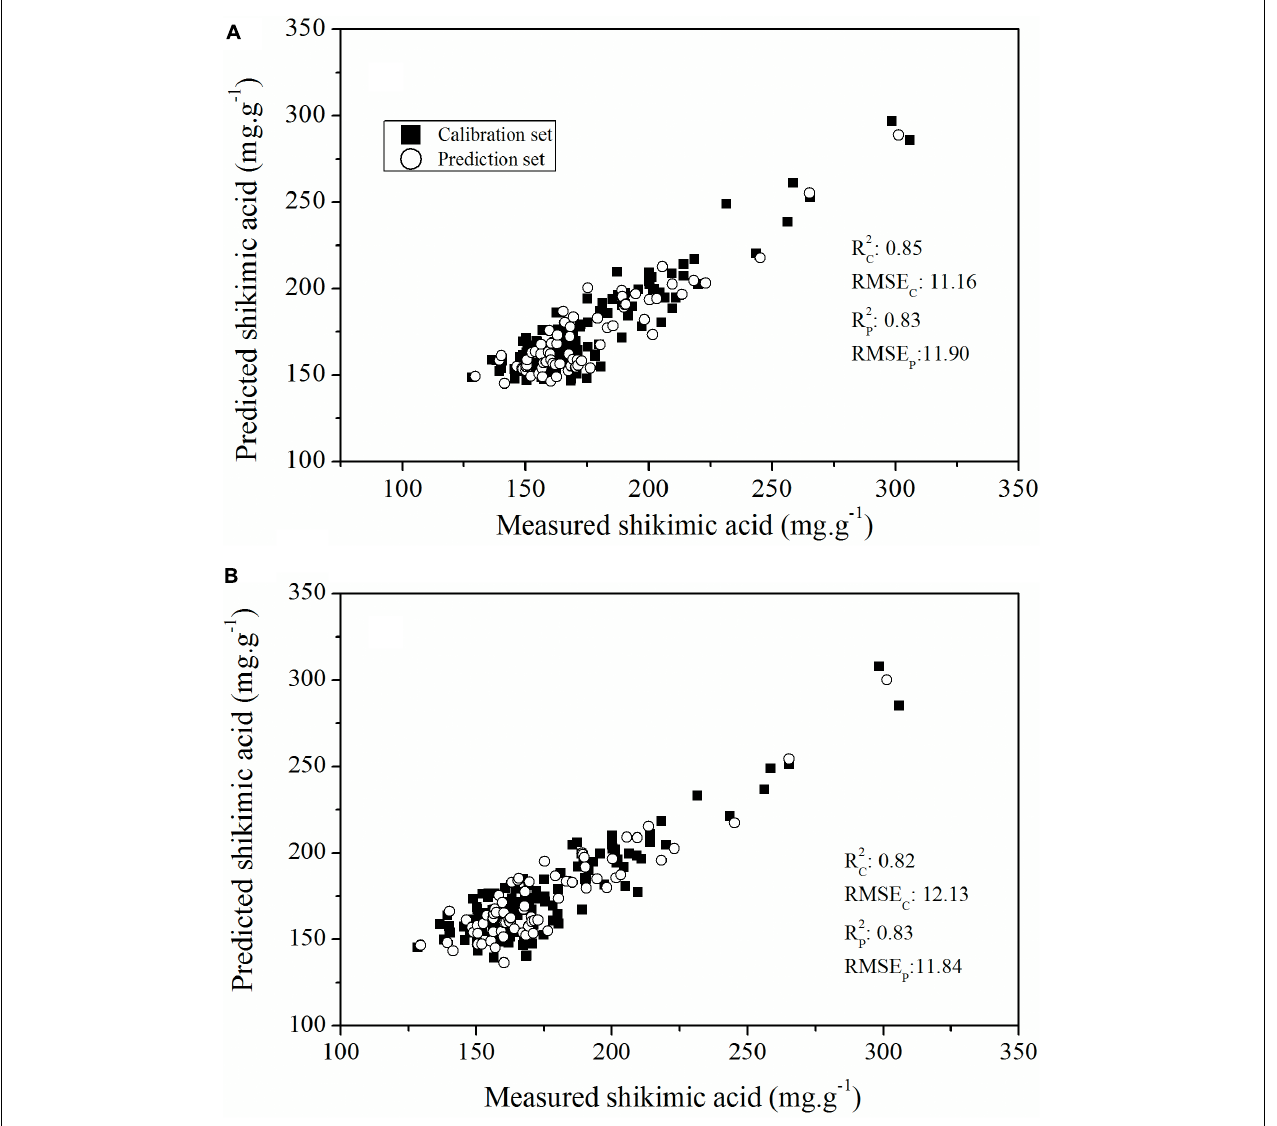
FIGURE 10 | Plot of reference vs. predicted values of shikimic acid concentration, derived from the PLSR model based on all the ChlF parameters (A) and the sensitive features (B)